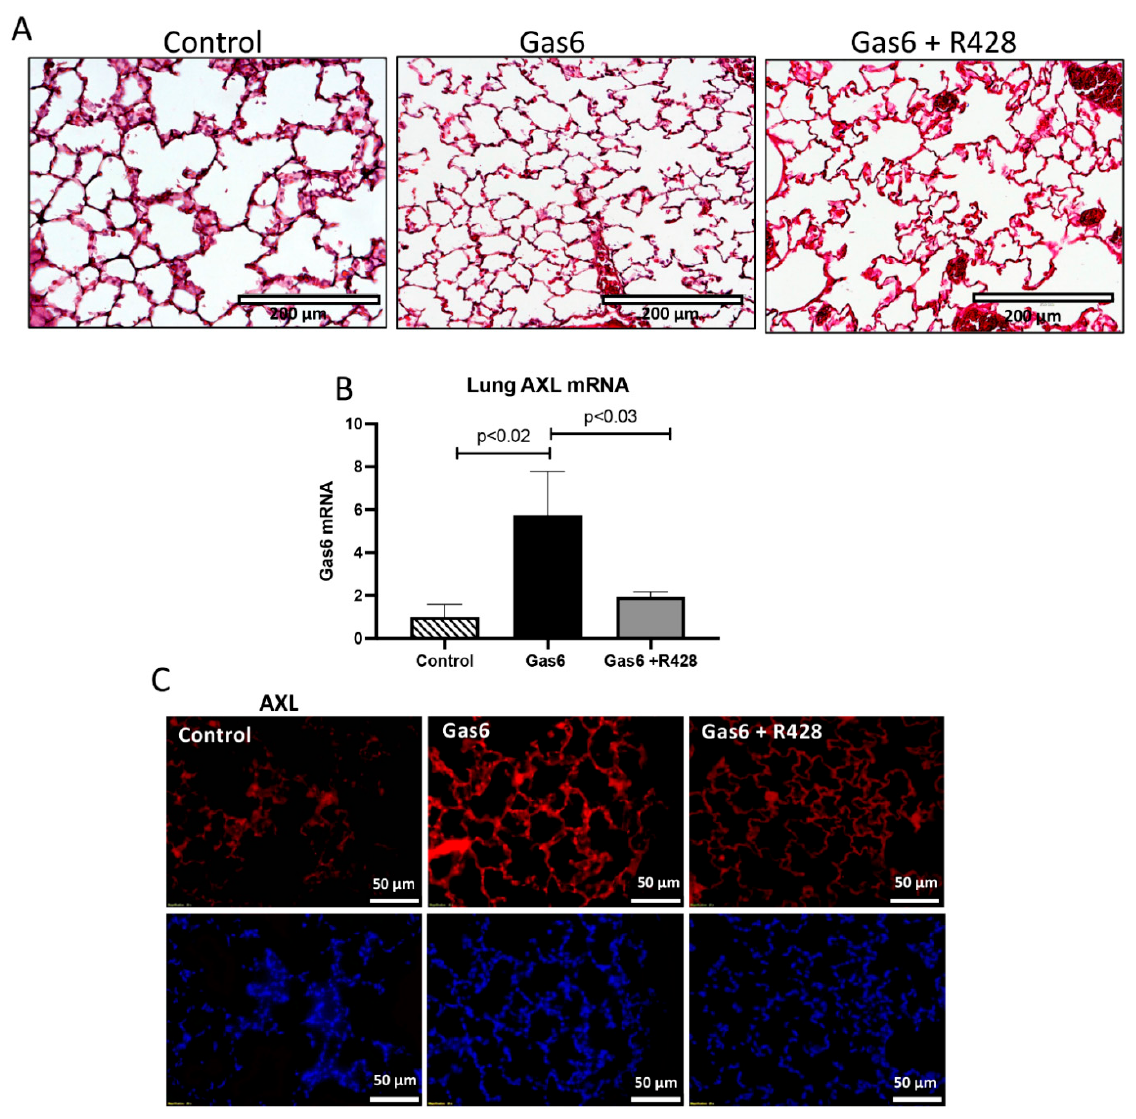
Figure 2. Lung AXL expression during Gas6 treatment in the pregnant rat. Hematoxylin staining was performed for lung structure determination ( A ). There was an increase in AXL mRNA in the treated animals as compared to controls ( B ). This increase was also observed in AXL protein levels in the lung of treated animals as compared to controls ( C